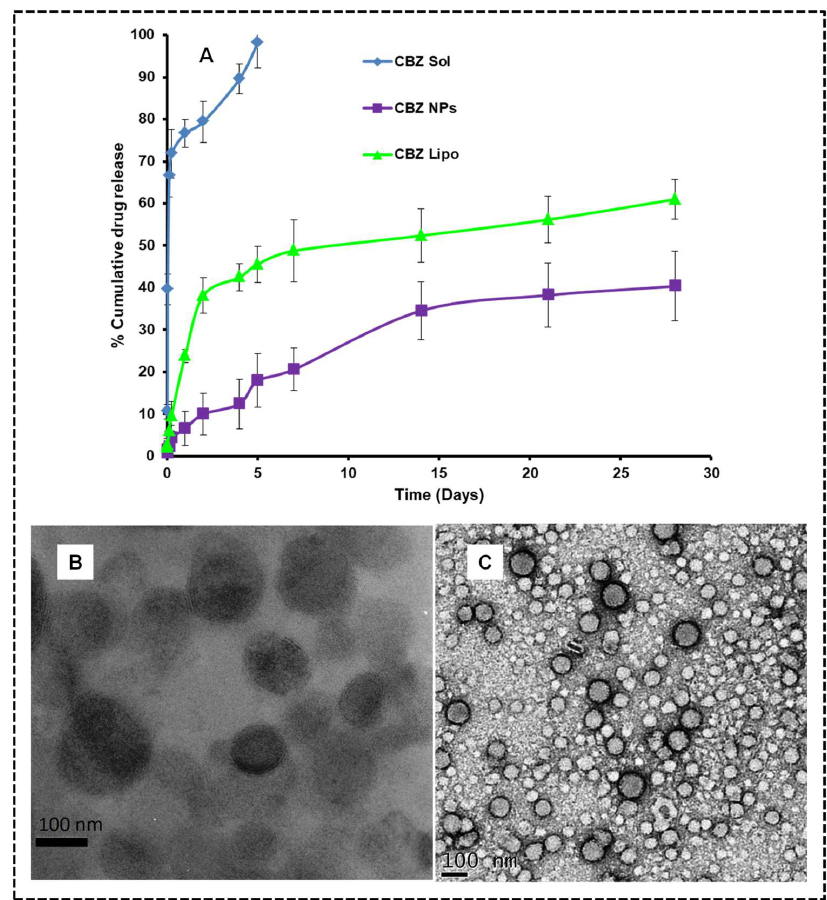
Figure 3. In vitro drug release and TEM images for optimized formulations: ( A ) The dialysis bag method was used to perform release studies in phosphate buffer saline (PBS) pH 7.4 (0.5% w / v